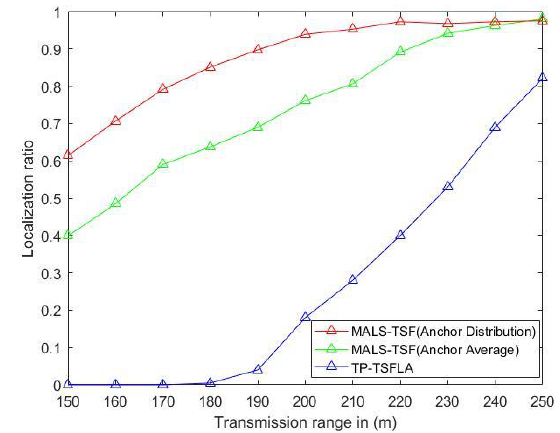
Figure 12. The localization ratio versus transmission range.